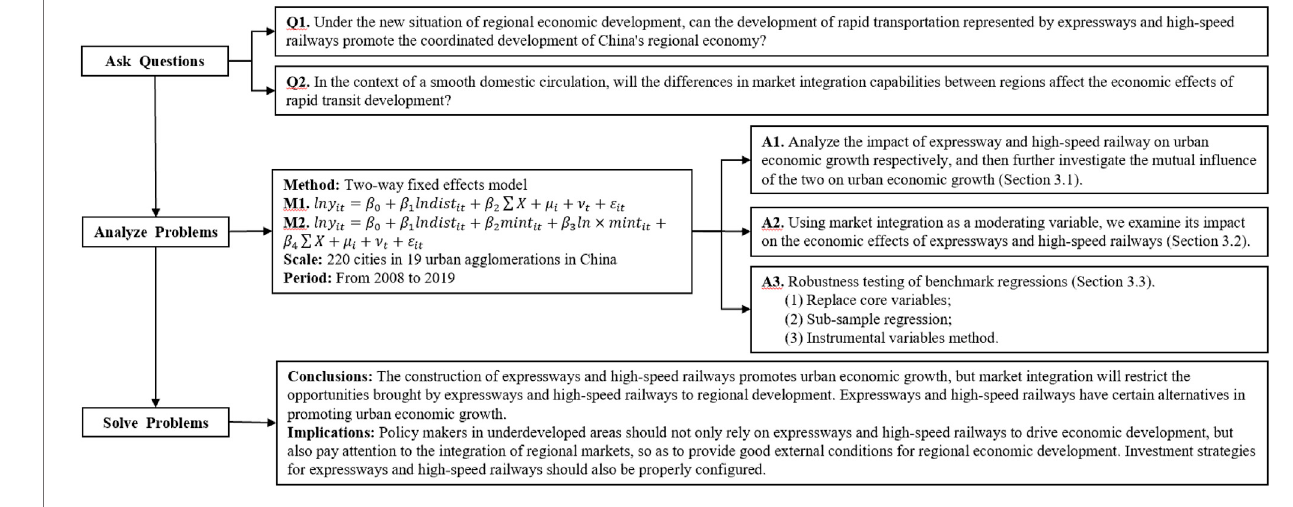
FIGURE 1 | Technical